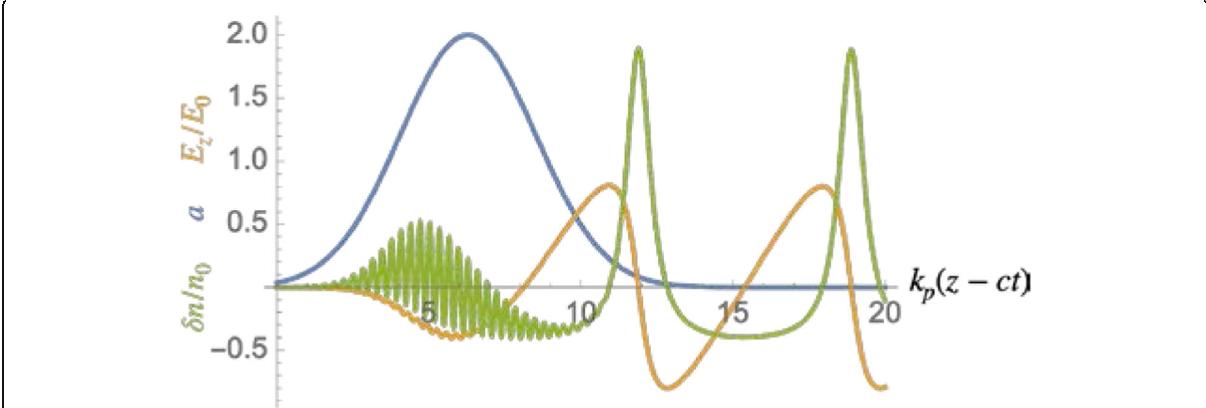
Fig. 12 Wakefield excitation in the non-linear regime. Laser pulse profile in blue, electron density modulation in green, and corresponding longitudinal field is shown in